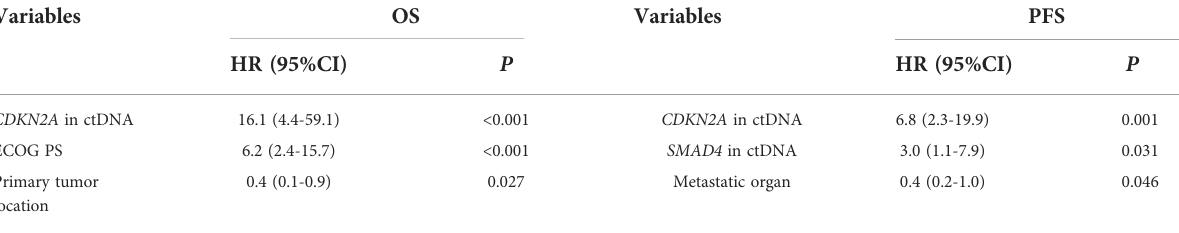
Adjusted for: Age, Sex, ECOG PS, Primary tumor location, Grade, Metastatic organ, Metastatic lesion location, CA19-9, CEA, NLR, PLR and KRAS/TP53/CDKN2A/SMAD4 in ctDNA; ctDNA, circulating tumor DNA; OS, overall survival; PFS, progression-free survival; CI, con fi dence interval; PAC, pancreatic adenocarcinoma; ECOG PS, Eastern Cooperative Oncology Group Performance